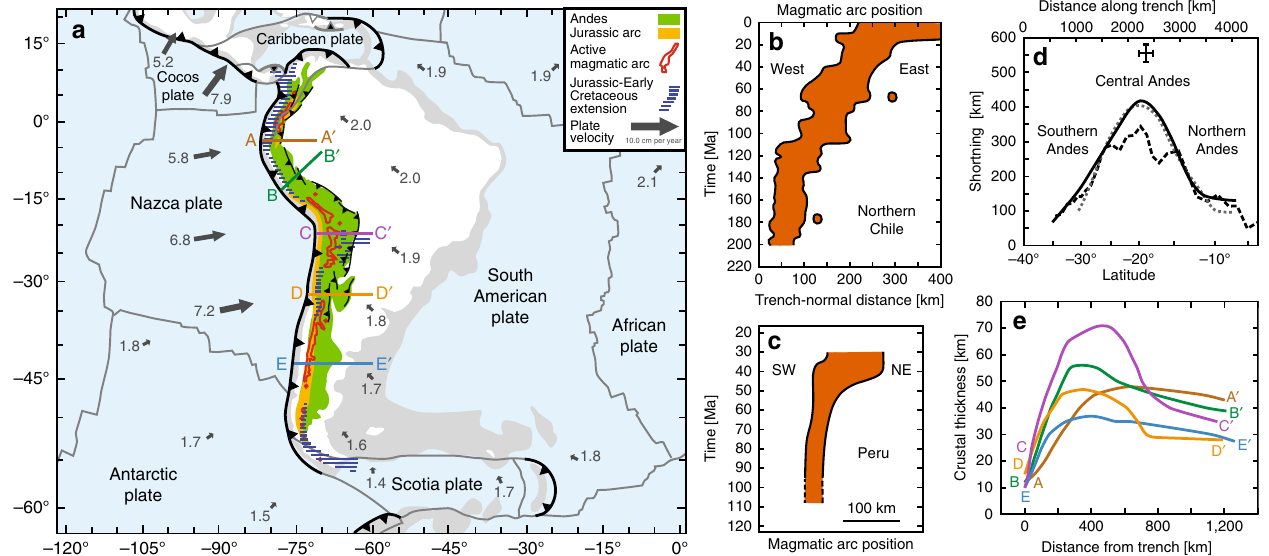
Fig. 1 Tectonics and geology of the Andes region. a Tectonic map showing the current plate velocities, the Andes mountain belt, Jurassic-Early Cretaceous extension in the Andean region 9 , the Jurassic magmatic arc (Methods section) and the present magmatic arc. Note that the fi ve transects (A-A ’ , B-B ’ , C-C ’ , D-D ’ , E-E ’ ) are shown in e . b , c Evolution of the magmatic arc position in Northern Chile (21° – 26°S, based on Scheuber et al. 8 ) and Peru (simpli fi ed from Jaillard and Soler 11 ). d Trench-parallel variation in Andean shortening. Continuous black line is based on balanced cross-sections and Eocene-present tectonic reconstruction 19 , dotted grey line is based on Eocene-present tectonic reconstruction 18 , dashed black line is based on crustal thickness (assuming an original thickness of 40 km) 17 , and Central Andes data point is based on structural mapping of Late Cretaceous-present deformation 12 . e Pro fi les showing the crustal thickness in fi ve locations (see a ) along the Andes (derived from the crustal thickness map of Chulick et al. 20